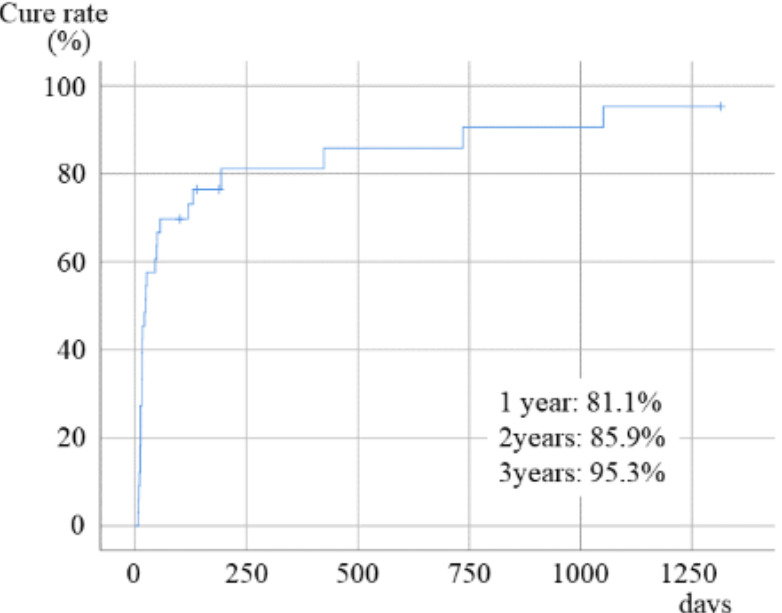
Figure 2. Healing rate of MRONJ after surgery.